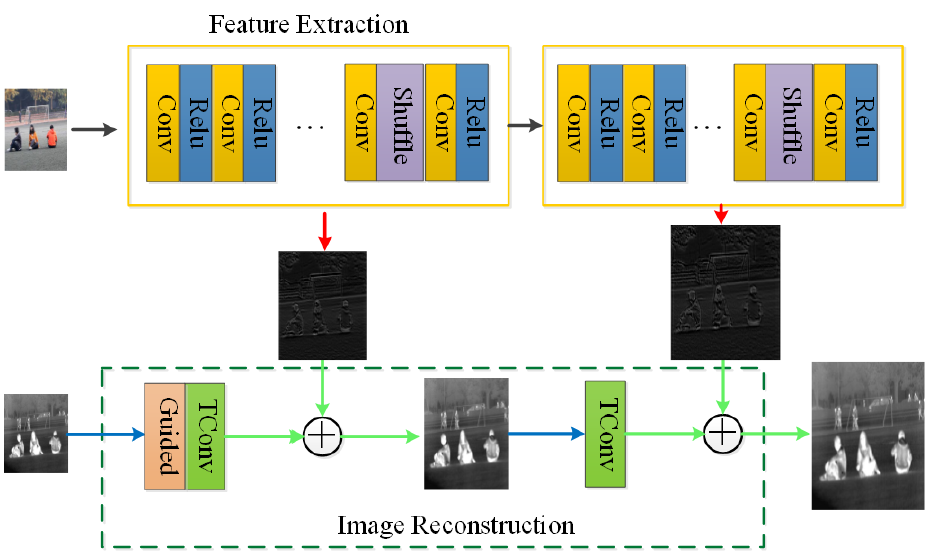
Figure 3. RGB-IR cross input and sub-pixel upsampling Network architecture. (the red arrow represents feature extraction, the green arrow represents the addition of the extracted feature and the upsampled feature, and the blue arrow represents the upsampling